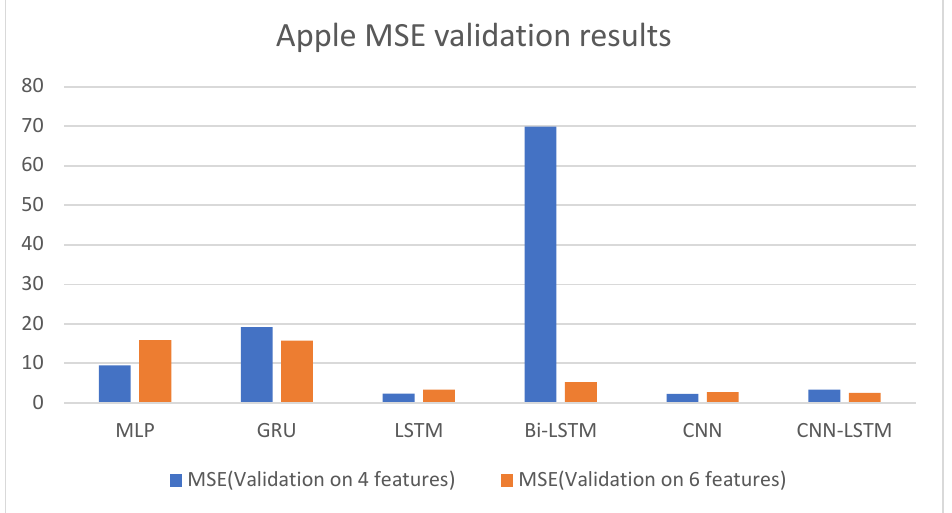
Figure 5. The visualization of the MSE results of Apple .